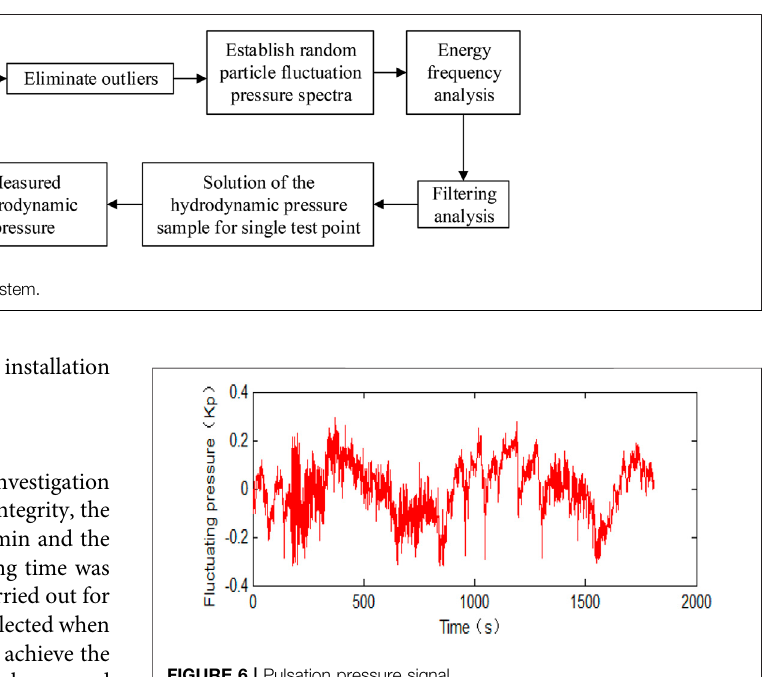
FIGURE 6 | Pulsation pressure